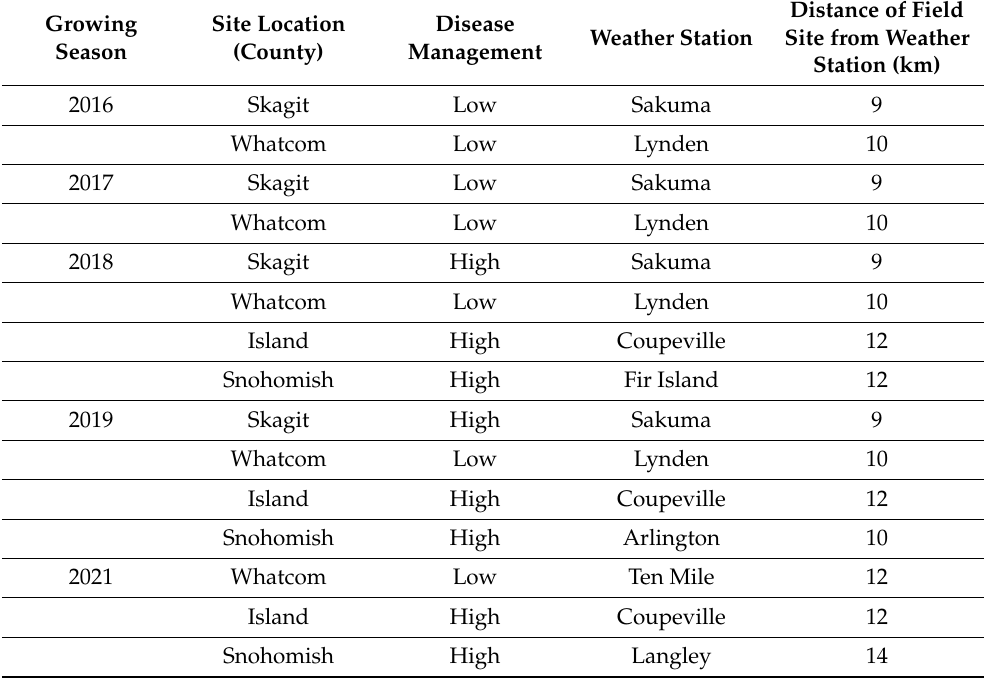
Table 1. Field sites in northwestern Washington monitored for Monilinia vaccinii-corymbosi apothe- cia during the 2016–2019 and 2021 study periods. Data were not collected during the 2020 growing